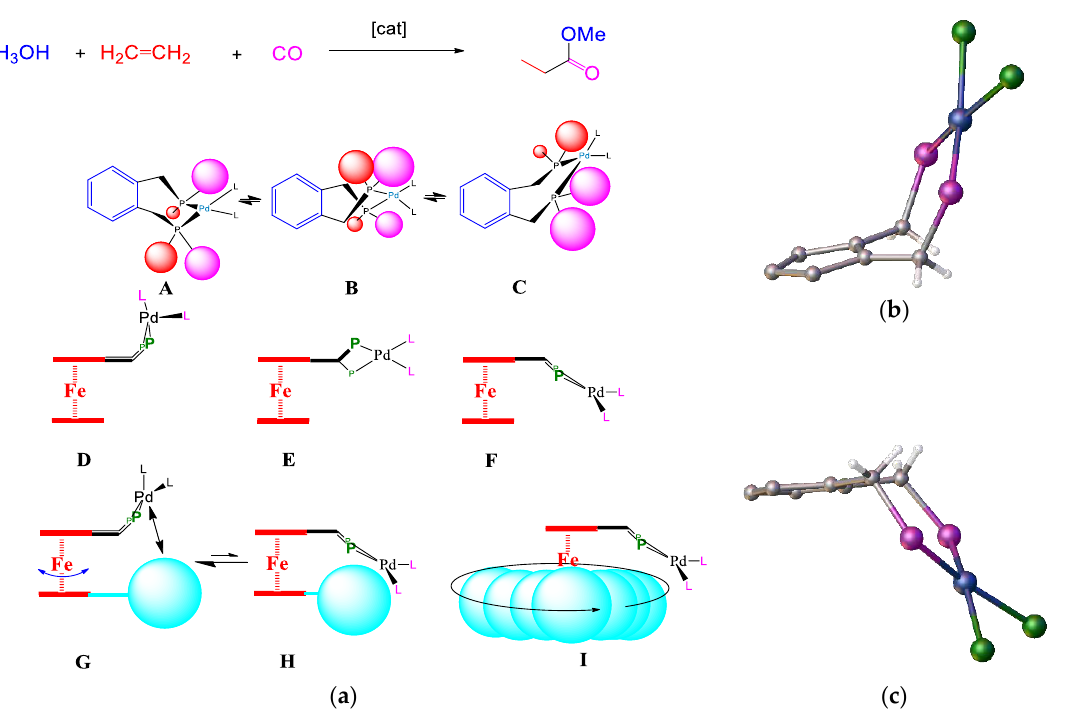
Figure 15. ( a ) Conformational flipping of A – C with the Alpha catalyst, and D – I with a ferrocenyl phosphane complex. At conformer D , the palladium sits above the cp ring. E , F show the flipping process. G – I show the steric blocking effect of a substituent on the bottom non-P ring. ( b ) flipping of Pd centre above Cp plan and ( c ) flipping below cp plane.